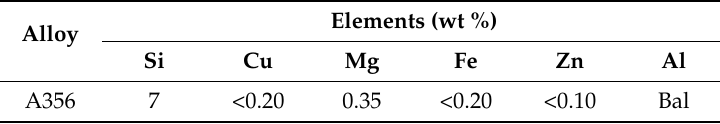
Table 1. Composition of A356 alloy used in the present